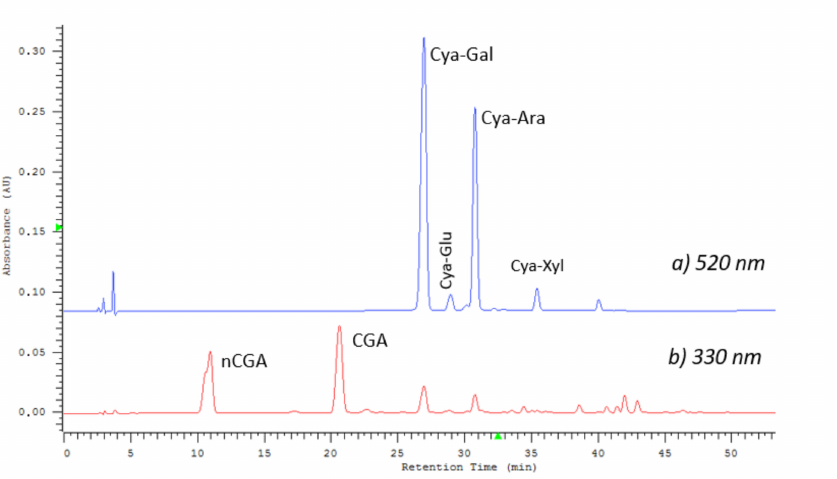
Figure 6. A typical HPLC chromatogram of Aronia anthocyanins (LE6 extract from August 7), registered at 520 nm ( a ). For comparison, the chromatogram at 330 nm ( b ) registered simultaneously for the same sample is shown below, with visible peaks of chlorogenic acids. Abbreviations: CyaGlu (cyanidin 3-glucoside), CyaXyl (cyanidin 3-arabinoside).